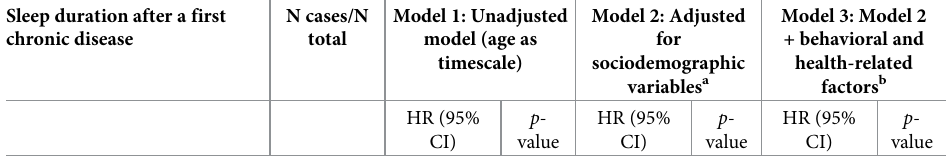
Table 4. Association of sleep duration after a first chronic disease with transitions from first chronic disease to multimorbidity and mortality ( N = 3,702). Sleep duration after a first chronic